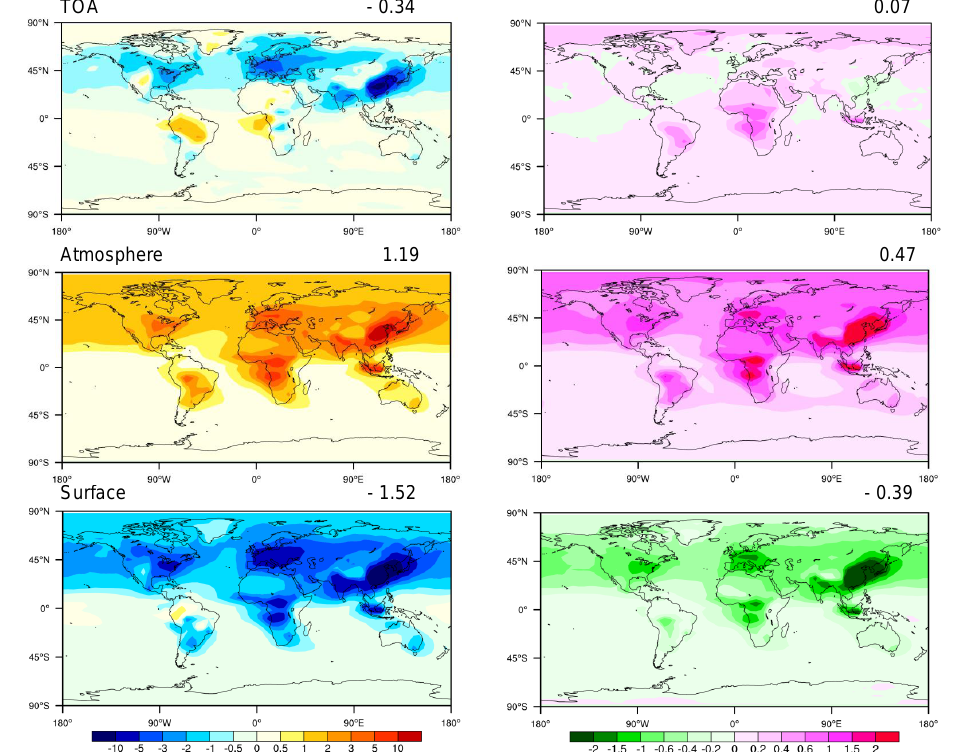
Fig. 12. Same as Fig. 11 but for the results from the experiment